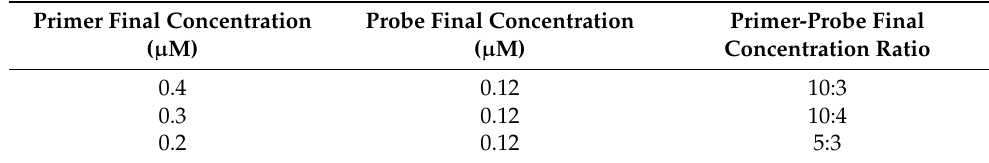
Table 4. Primer-probe